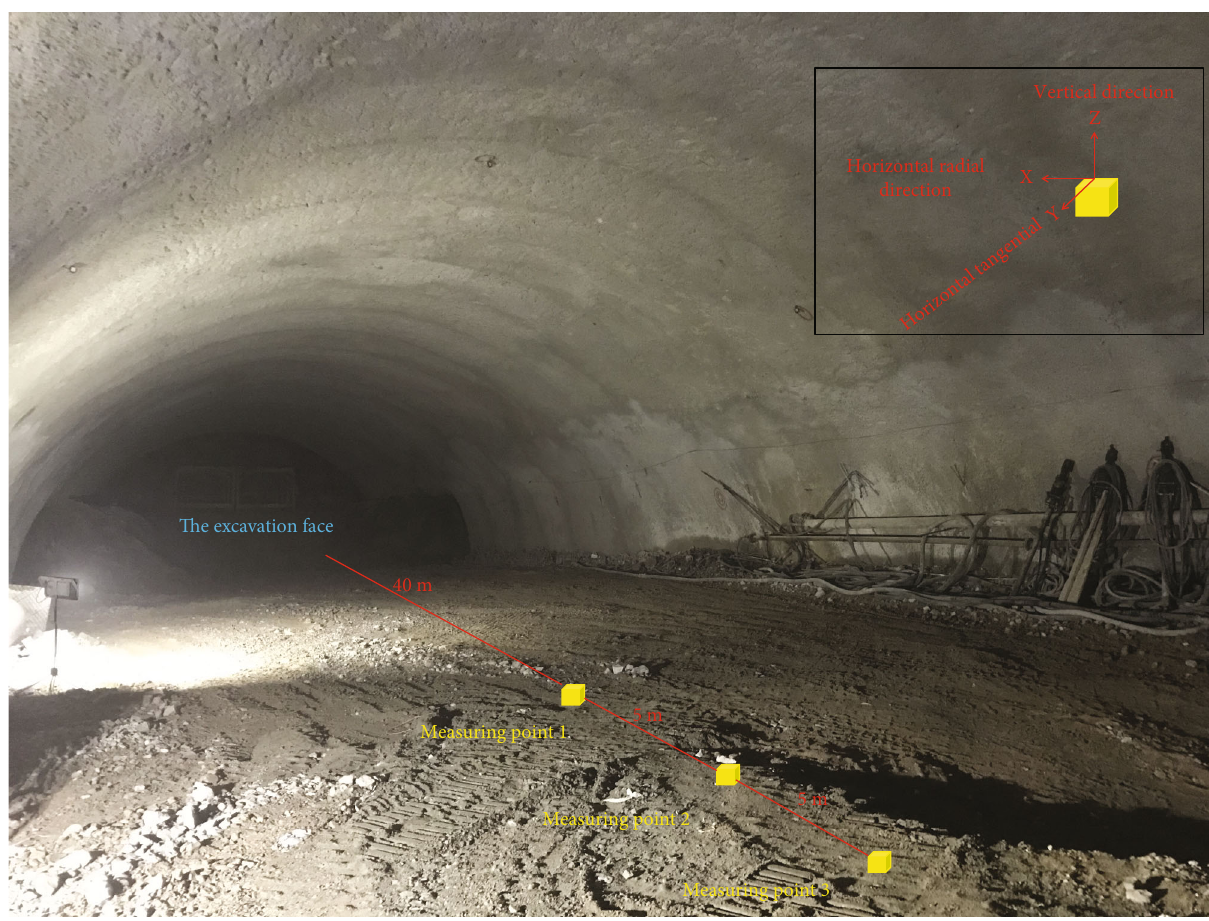
Figure 2: Layout of bottom plate measuring